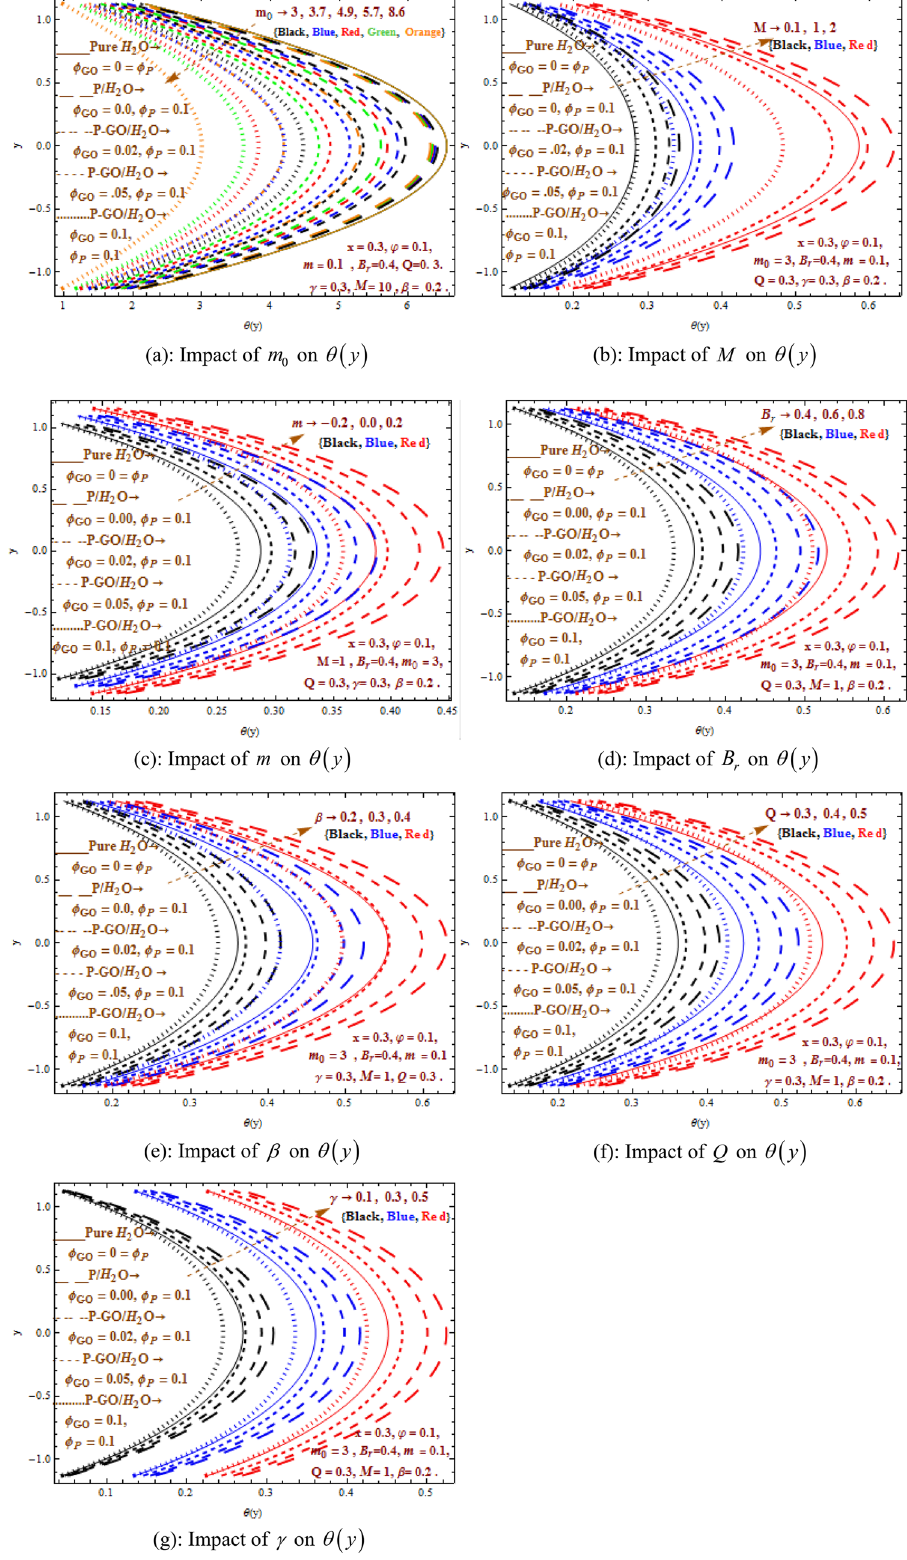
Figure 2. ( a ) Impact of m 0 on